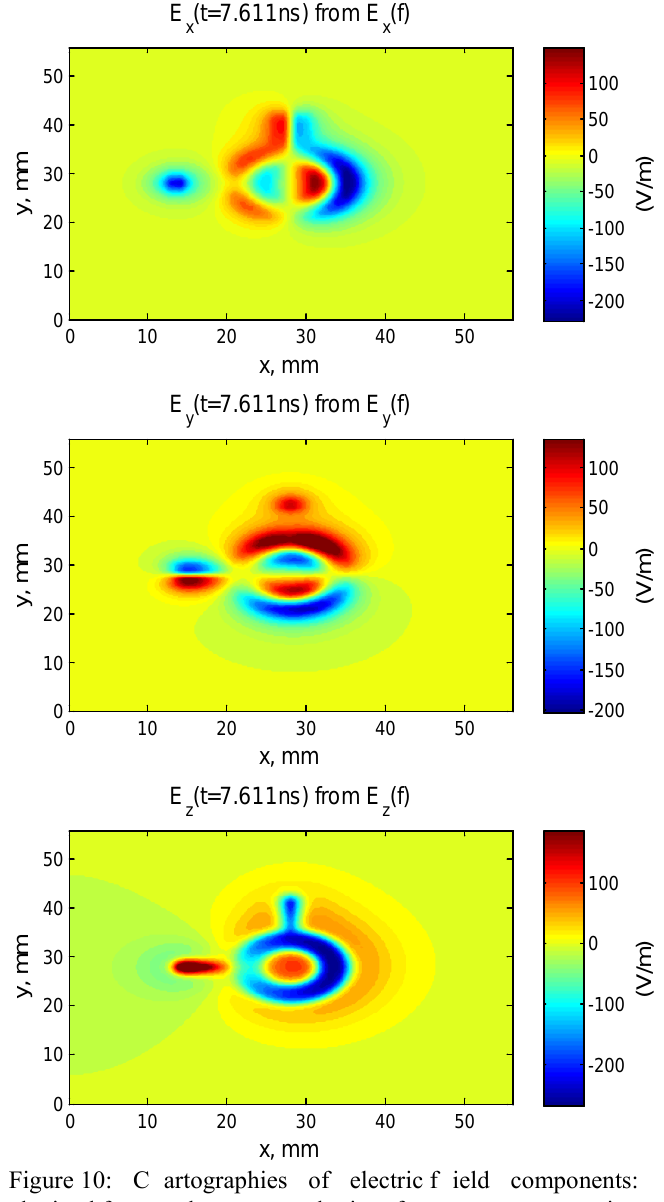
Figure 10: C artographies of electric f ield components: obtained f rom t he pr oposed t ime-frequency c omputation method.